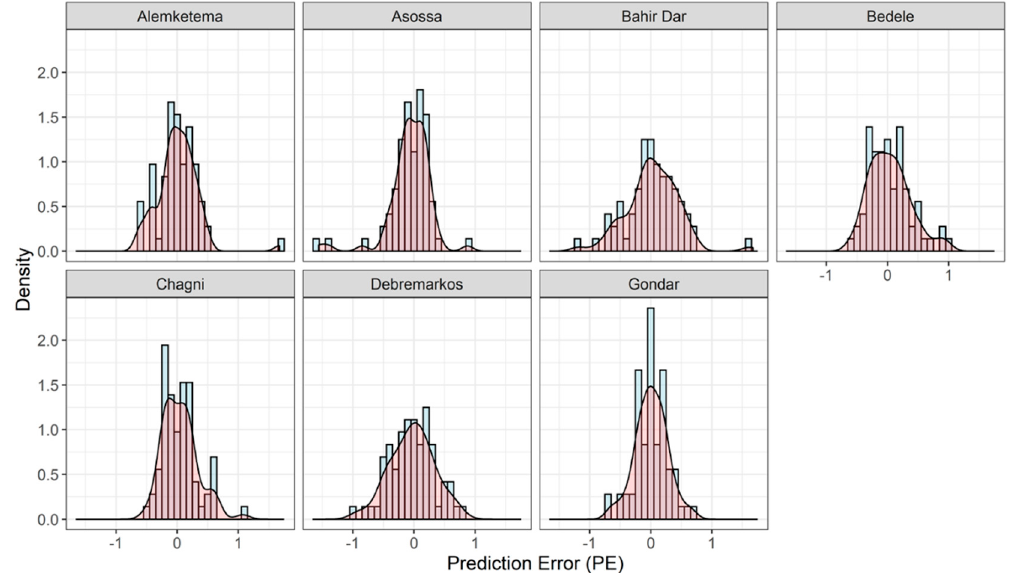
Figure 8. Density plots and histograms of the prediction error ( PE ) values calculated for the test